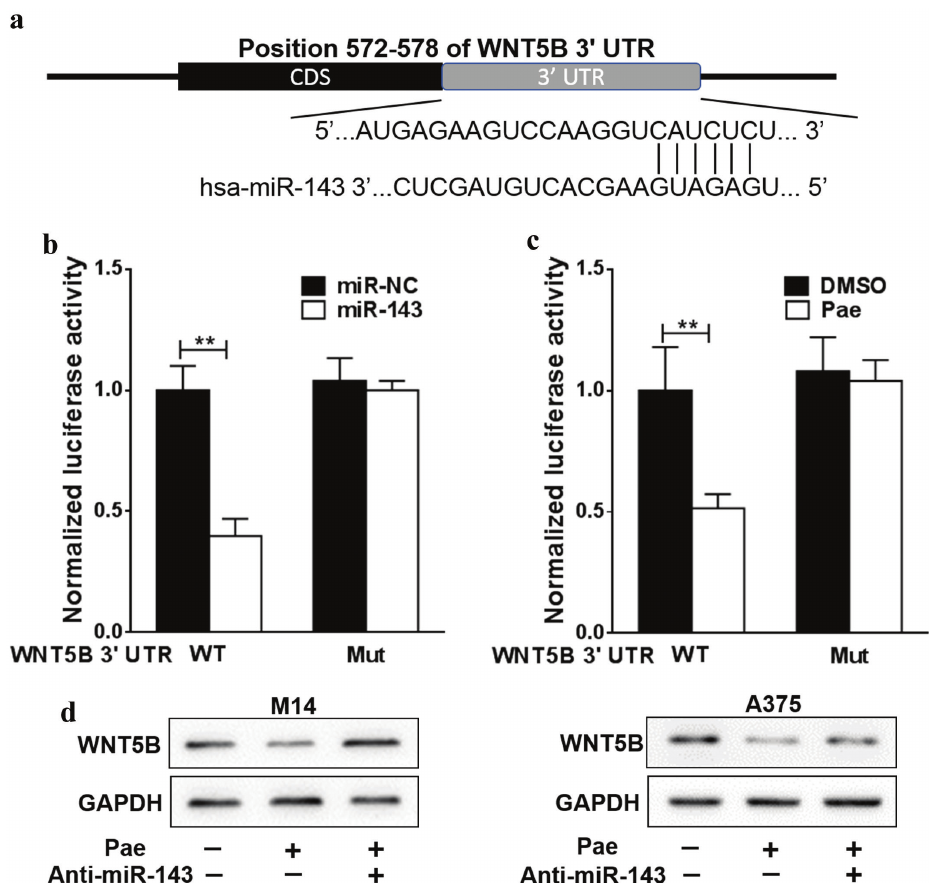
Fig. 4 . WNT5B is the target of miR-143 and is suppressed by paeonol (Pae). (a) Putative seed-matching sites between miR-143 and 3 ′ -UTR of WNT5B. (b) The WT and mut WNT5B 3 ′ UTR reporters were constructed and were co-transfected with miR- 143 mimics or miR-NC mimics in M14 cells, after 24 h the luciferase activities were analyzed. (c) The WT and mut WNT5B 3 ′ UT reporters were transfected in M14 cells, and were treated with 500 μM Pae or DMSO. After 24 h the luciferase activities were analyzed. (d, e) M14 and A375 melanoma cells were transfected with Anti-miR-143 or Anti-miR-NC, and were treated with 500 μM Pae or DMSO, and western blotting were used to test the expression levels of WNT5B. ** P < 0.01 versus control.